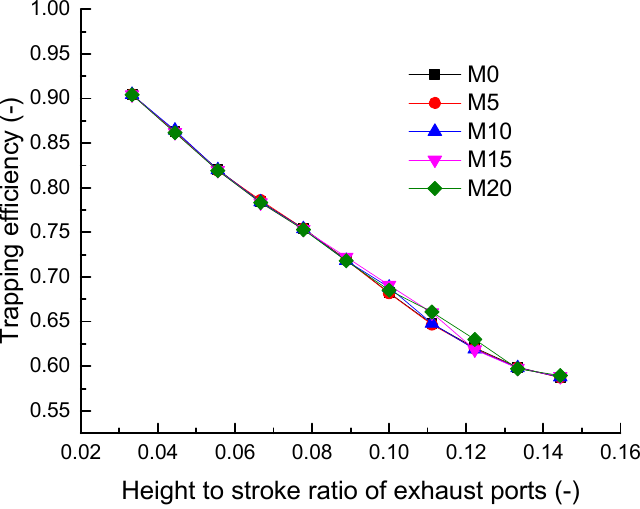
Figure 7. Trapping efficiency for different height to stroke ratios of the exhaust ports.